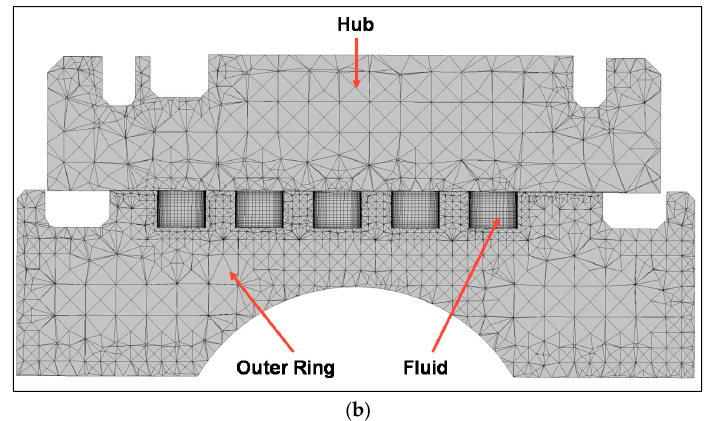
Figure 15. ( a ) The Outer ring of the bearing. On the LHS, the oil inlet and outlet of the outer ring cooling duct and the position of the heat flux into the material by the rolling elements are shown. On the RHS the inlet and outlet are shown and also the interface to the SQF; ( b ) A perpendicular cut through the mesh (Outer ring, Fluid and Hub).